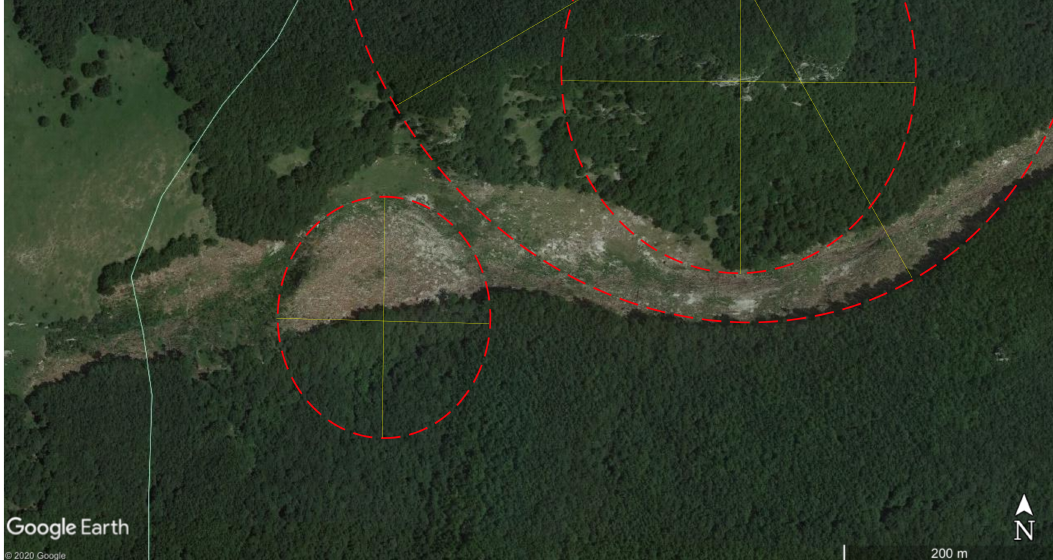
Figure 5. Orthophoto of 25 June 2017 (©2020 Google), showing the pronounced shoulder at 1500m a.s.l. and the bend at 1300m a.s.l. The trimline is at the transition from light foliage to dark shadows. Contour lines (equidistance 10m) computed from a DTM with 10m resolution [13]. Red dotted lines are ellipses used for estimating curvature radii in bends, with major axes in